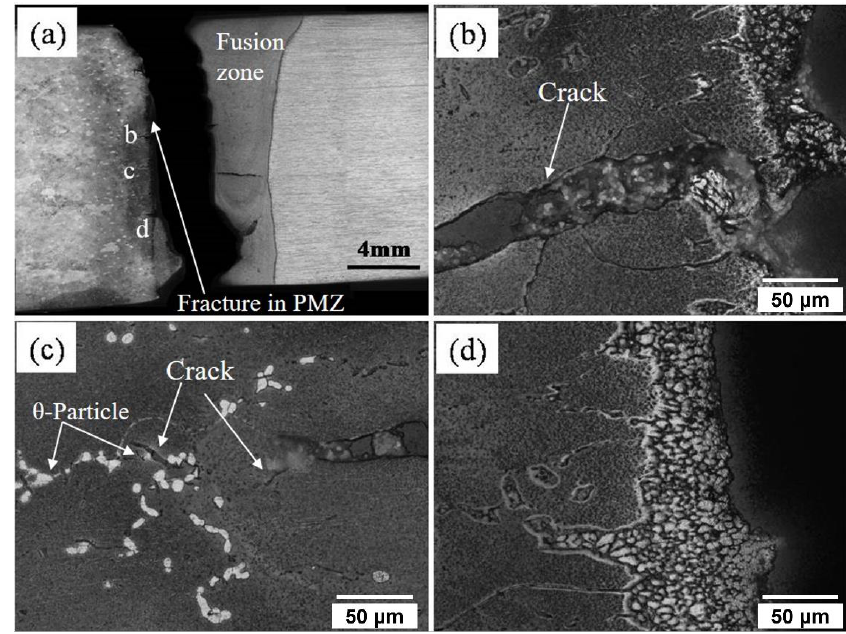
Figure 16. ( a ) Optical macrograph of a fractured tensile-test specimen of dissimilar EB weld; ( b , c ) microstructures of cracks existing near θ -particle fractured region in PMZ of AA 2219 side; ( d ) mi- crostructure of crack propagated in FZ from PMZ.